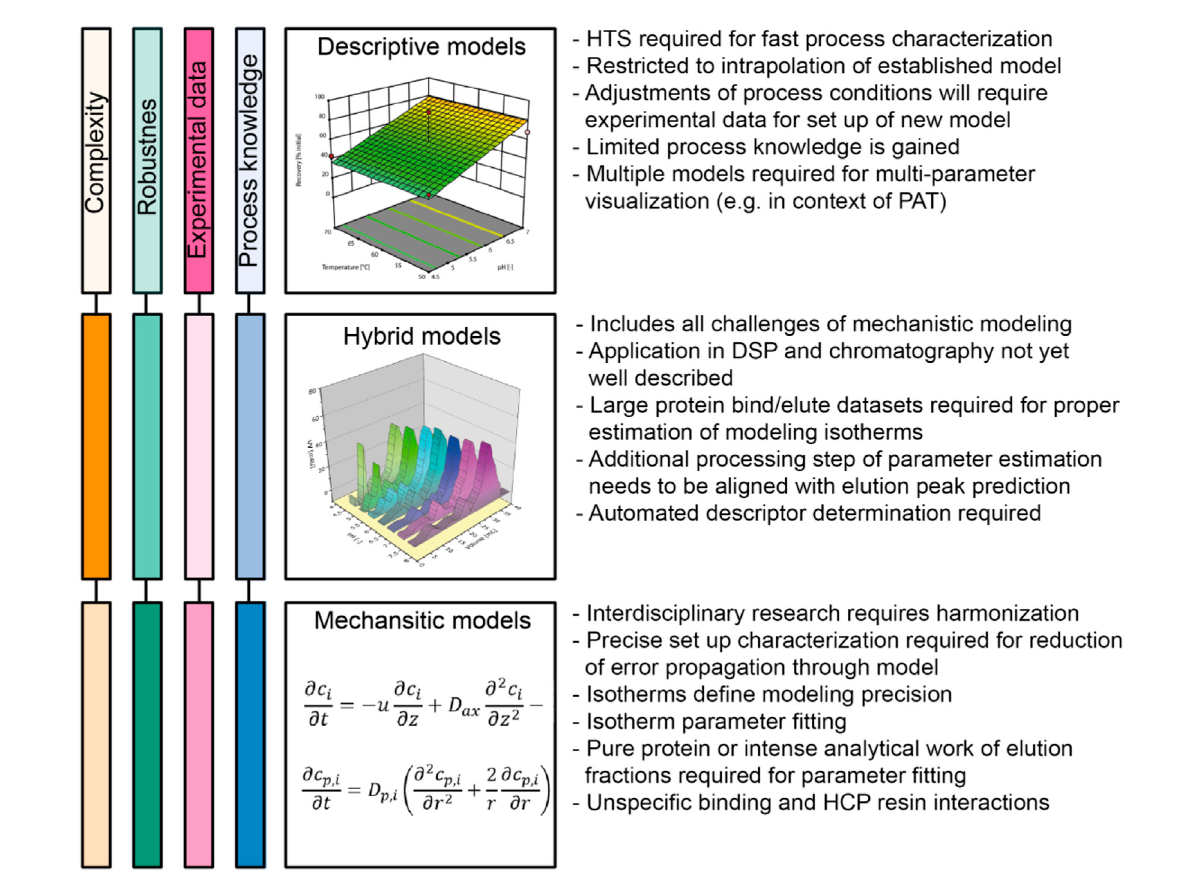
FIGURE 4 Comparison of data-driven, mechanistic and hybrid chromatography models. Color intensities correlate with the peculiarity/gravitas of the respective criterion for the respective model type. Here, complexity includes the mathematical frame of the model as well as efforts for model implementation,whereasrobustnessisde fi nedbytheaccuracyofmodelpredictionsandthecapabilityofextrapolationoutsidethecalibrationscale. Experimental data accounts for the number of experimental effort required for model calibration and validation and process knowledge summarizes the mechanistic information and process understanding provided by the model. DSP, Downstream processing; HCP, host cell protein; HTS, high-throughput screening; PAT, process analytical